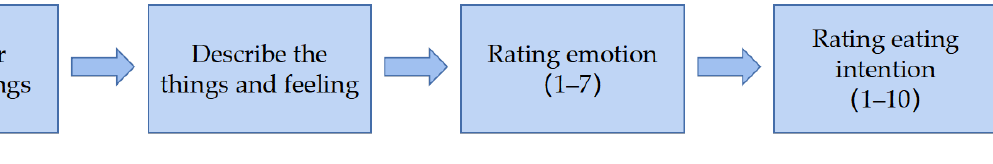
Figure 3. Procedure diagram.